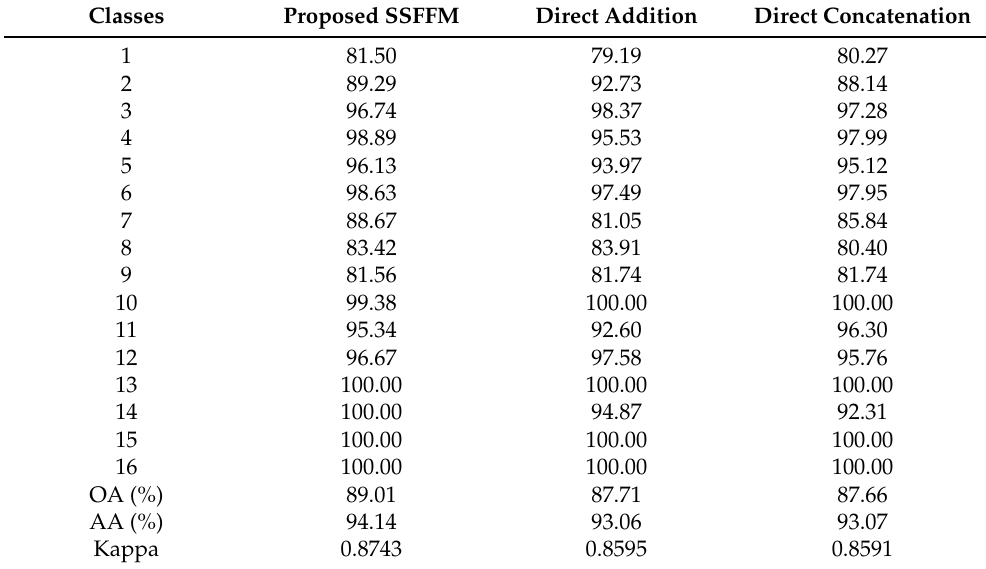
Table 10. Ablation study of various fusion methods on Indian Pines dataset.